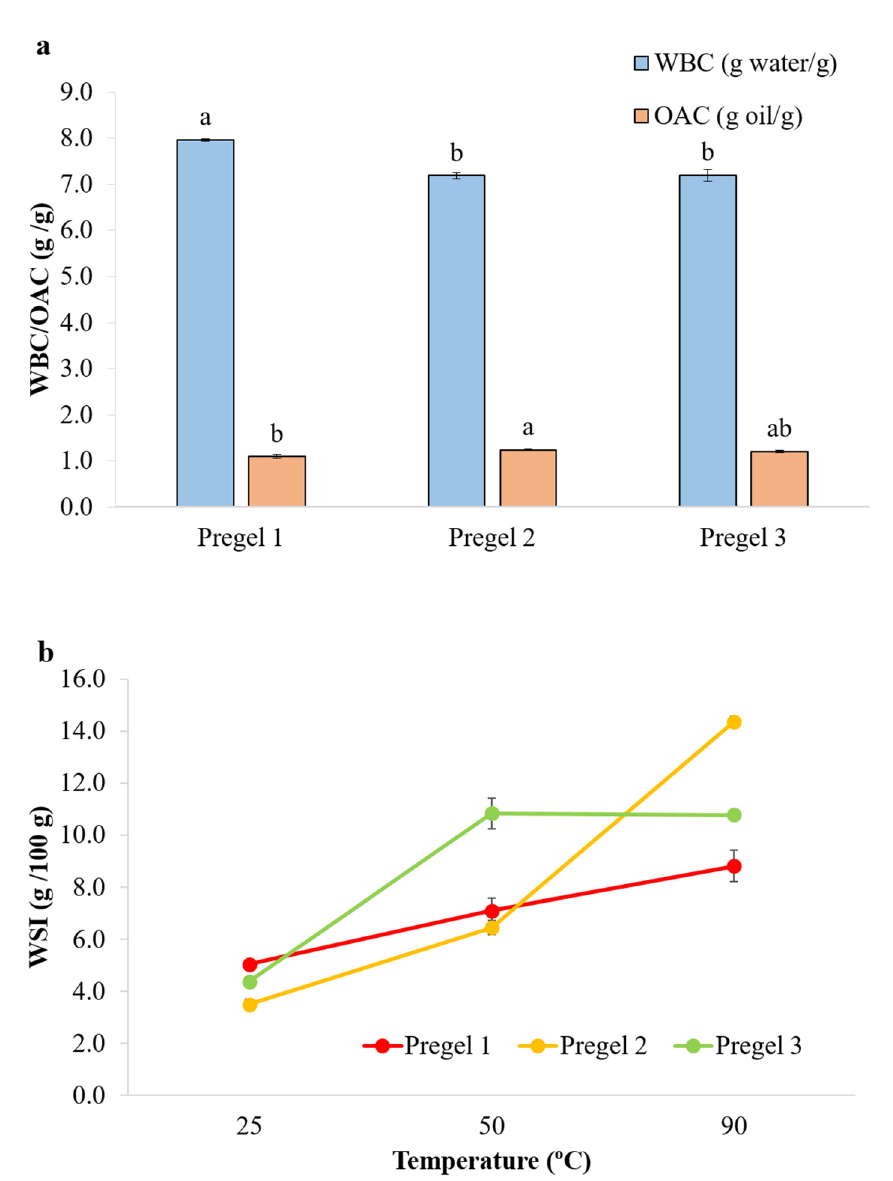
Figure 3. ( a ) Water binding capacity (WBC, g/g) and oil absorption capacity (OAC, g/g) of wheat starches at room temperature. Different lowercase letters above each bar denote significant differences. ( b ) Water solubility index (WSI, g/100 g) of wheat starches at three different